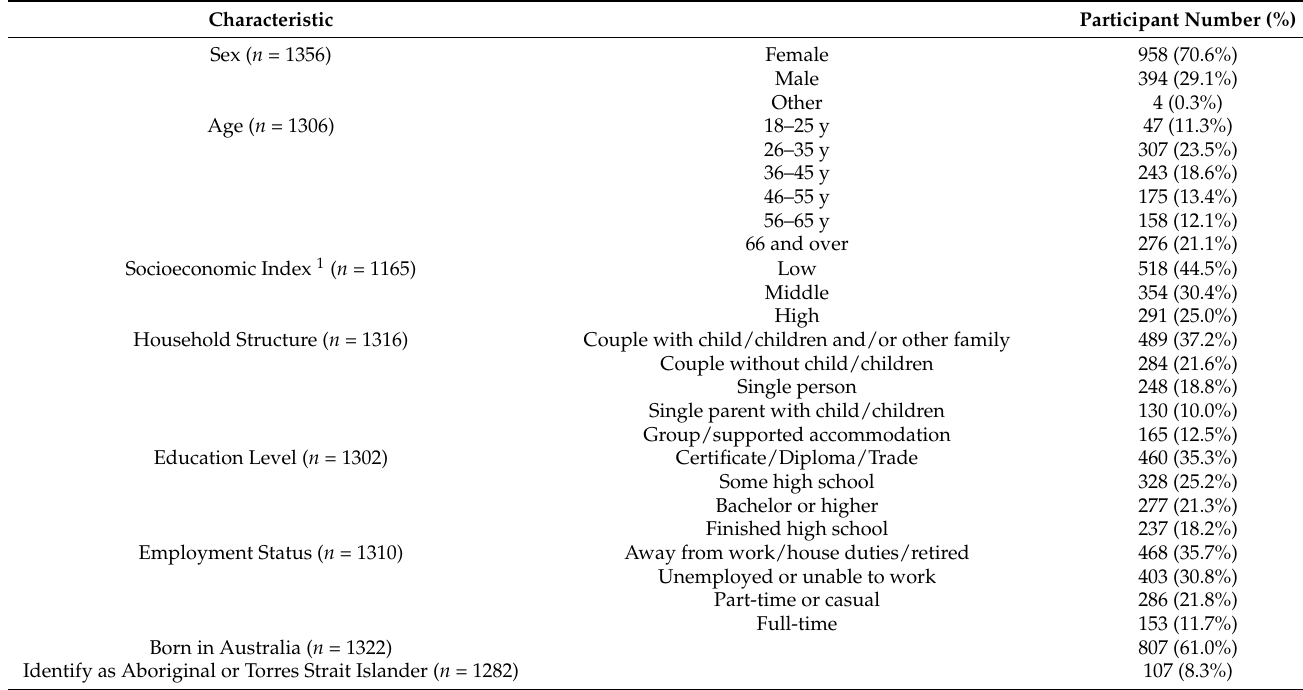
Table 2. Demographic characteristics of program attendees completing the start of program questionnaire.